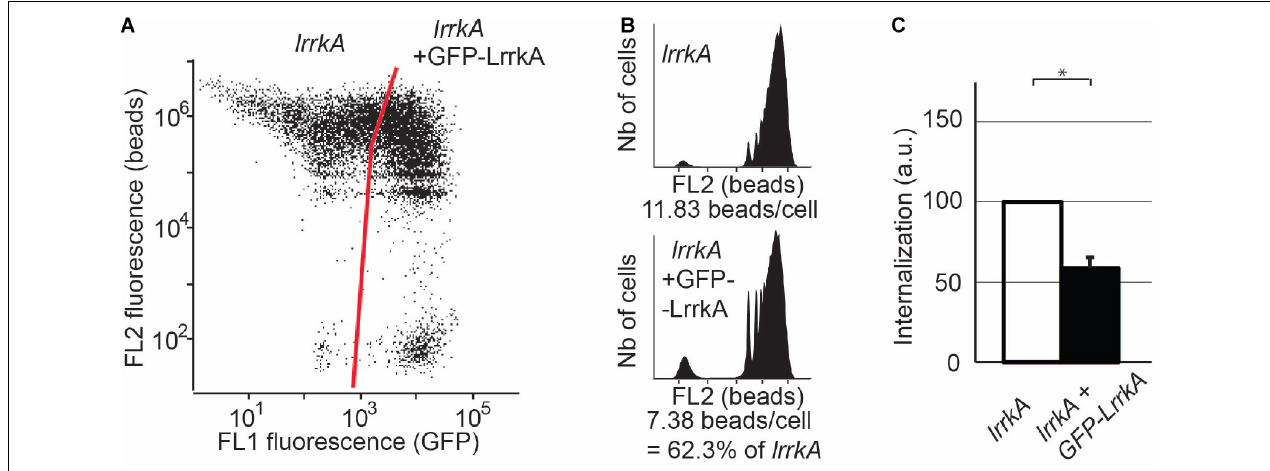
FIGURE 4 | Reexpression of LrrkA decreases phagocytosis in lrrkA KO cells. (A) Expression of GFP-LrrkA in lrrkA KO cells was assessed by flow cytometry. After 5 days of culture with no G418 selection, approximately 75% of transfected cells exhibited detectable GFP-LrrkA, while 25% did not produce the protein. (B) Phagocytosis was assessed by flow cytometry in lrrkA KO cells expressing GFP-LrrkA and in non-expressing cells. (C) Phagocytosis in lrrkA KO cells expressing GFP-LrrkA was measured in five independent experiments and expressed as a percentage of phagocytosis in cells that did not express GFP-LrrkA (mean ± SEM, ∗ p < 0.05, Mann–Whitney test, N = 5 independent